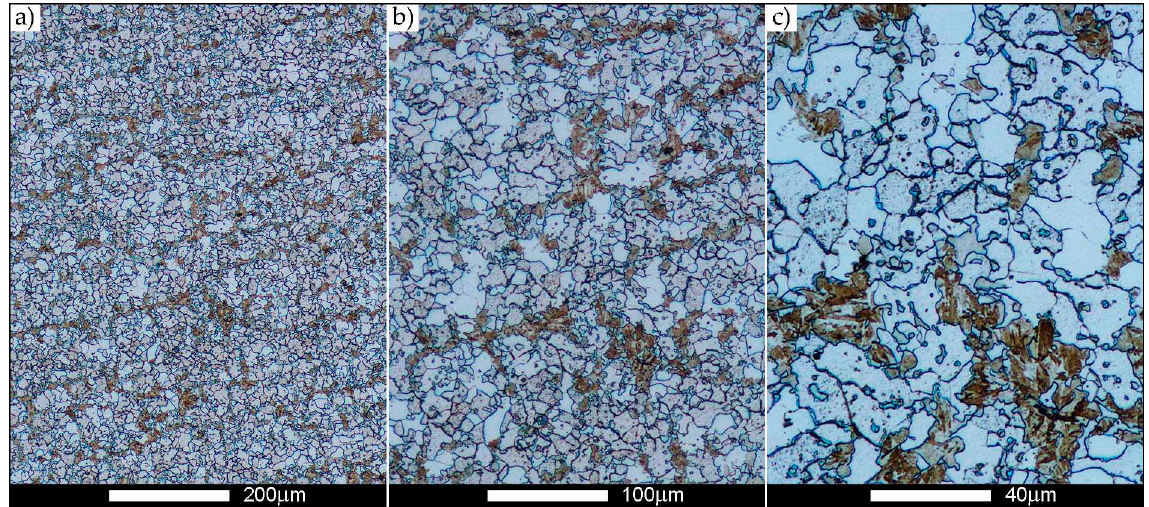
Figure 37. Welded joint microstructure of Hardox 450 steel in the normalised state with visible grain boundaries of prior austenite—WM2 zone shown in Figure 2. ( a ) 100×; ( b ) 200×; ( c ) 500×.